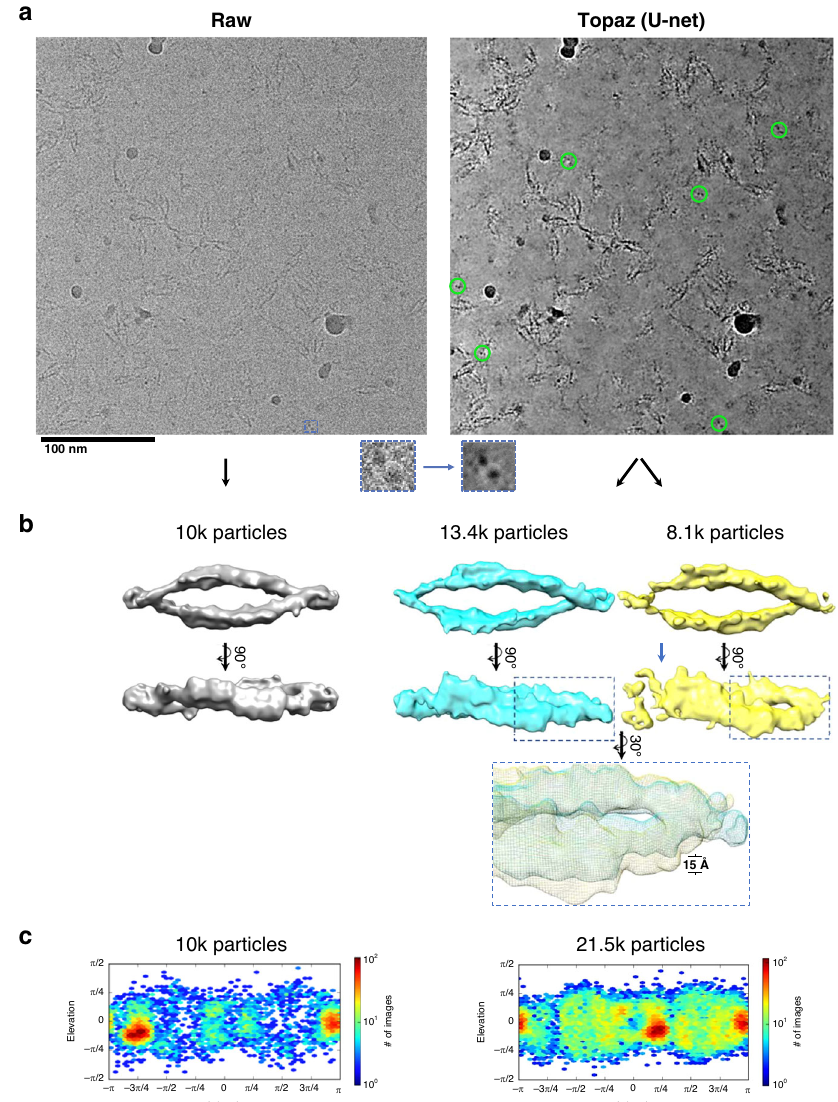
Fig. 2 Denoising with the general model in Topaz improves interpretability and picking of dif fi cult particle projections. a A raw micrograph (left) and Topaz-Denoised micrograph (right) of the clustered protocadherin dataset (EMPIAR-10234) with a top-view boxed out (insets). Denoising allows for top- views to be clearly identi fi ed (green circles, right) and subsequently used to increase the con fi dence and completion of particle picking. b Topaz picking training on raw micrographs using 1540 manually picked particles from the raw micrographs resulted in the reconstruction on the left. Topaz picking training on the raw micrographs using 1023 manually picked particles from the denoised micrographs resulted in the reconstruction on the right. Manually picking on denoised micrographs resulted in 115% more particles in the 3D reconstruction, which allowed for classi fi cation into a closed (blue) and putative partially open (yellow; blue arrow showing disjoint) conformation. The inset shows a zoom-in of the ~15 Å conformational change of the twist. c 3D reconstruction particle distributions for (left) Topaz picking training on raw micrographs using 1540 manually picked particles from the raw micrographs, and (right) Topaz picking training on the raw micrographs using 1,023 manually picked particles from the denoised micrographs. All particles from the two classes in ( b , right) are shown ( c , right). 3DFSC plots for the three maps shown here are in Supplementary Fig.